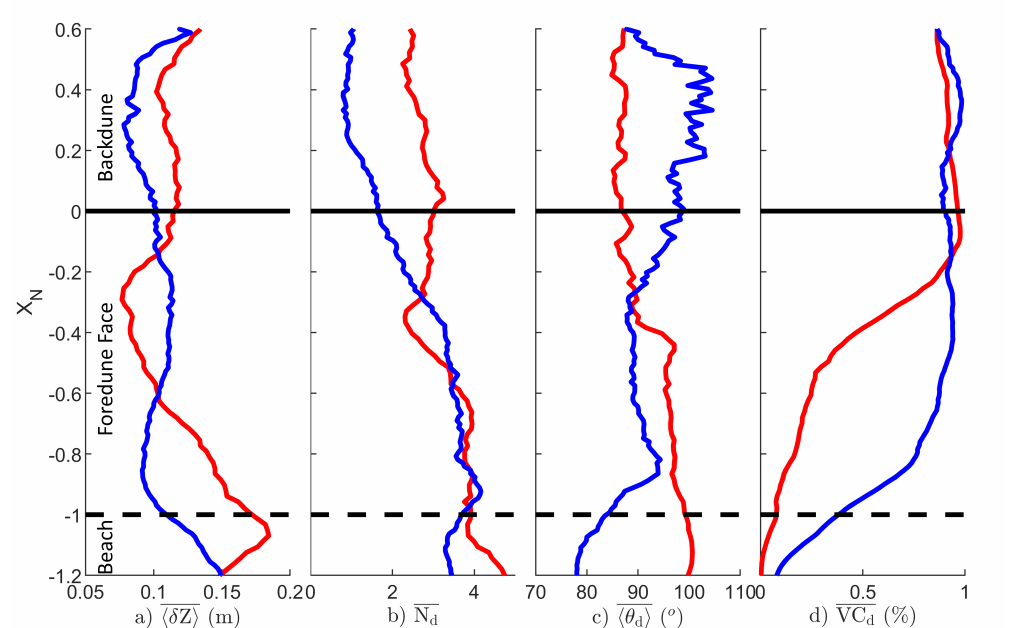
Figure 12. Site-specific trends in deposition characteristics. Normalized cross-shore position, X N , versus alongshore-averaged ( a ) deposition magnitude, (cid:104) δ Z i (cid:105) , ( b ) deposition occurrence, N d , ( c ) wind direction (cid:104) θ d (cid:105) , and ( d ) vegetation coverage, (cid:104) VC d (cid:105) for the north dune (red) and south dune (blue). The dune crest position is shown in a solid black line, and the dune toe position in a dashed black